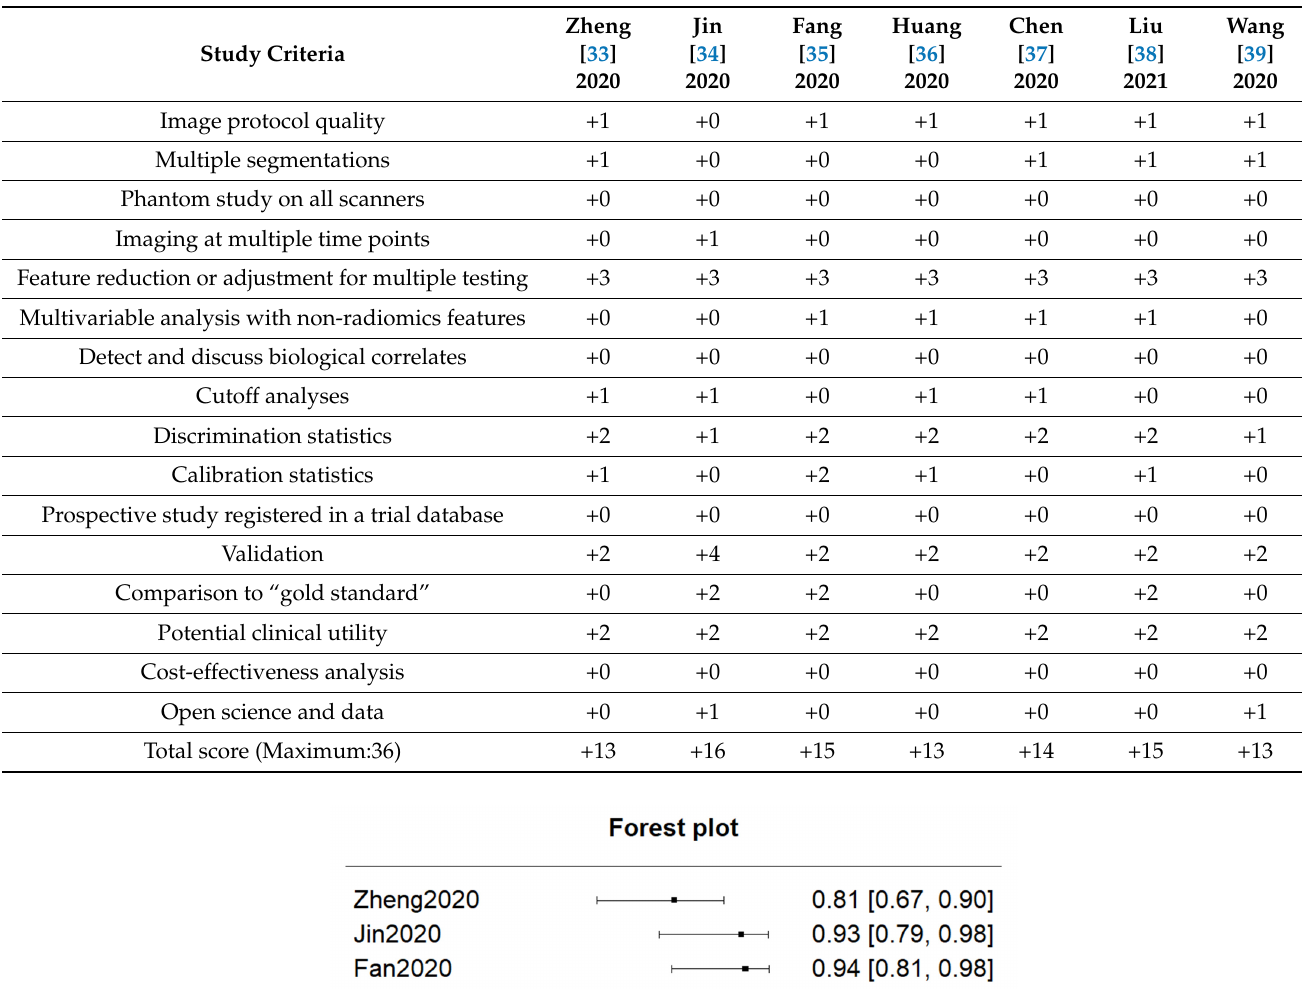
Table 2. Radiomics quality scores of the included studies.